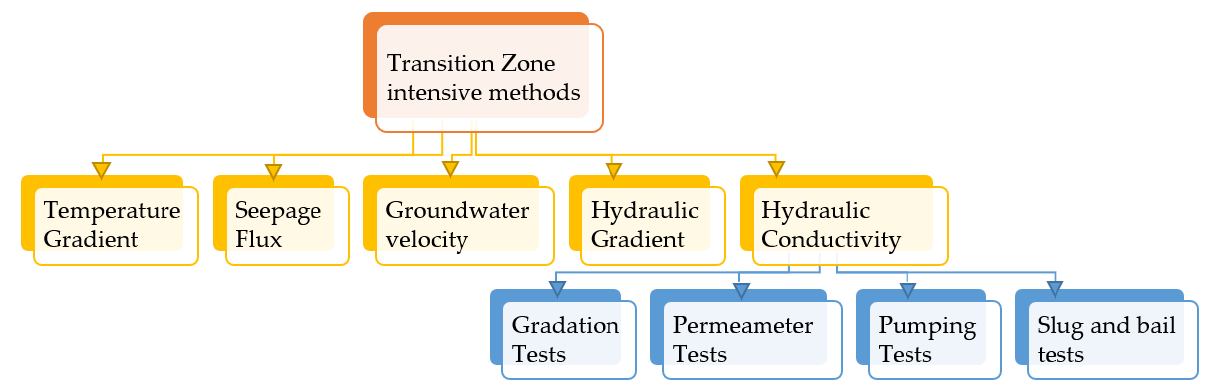
Figure 10. Methods for quantifying transition zone water interaction with groundwater.